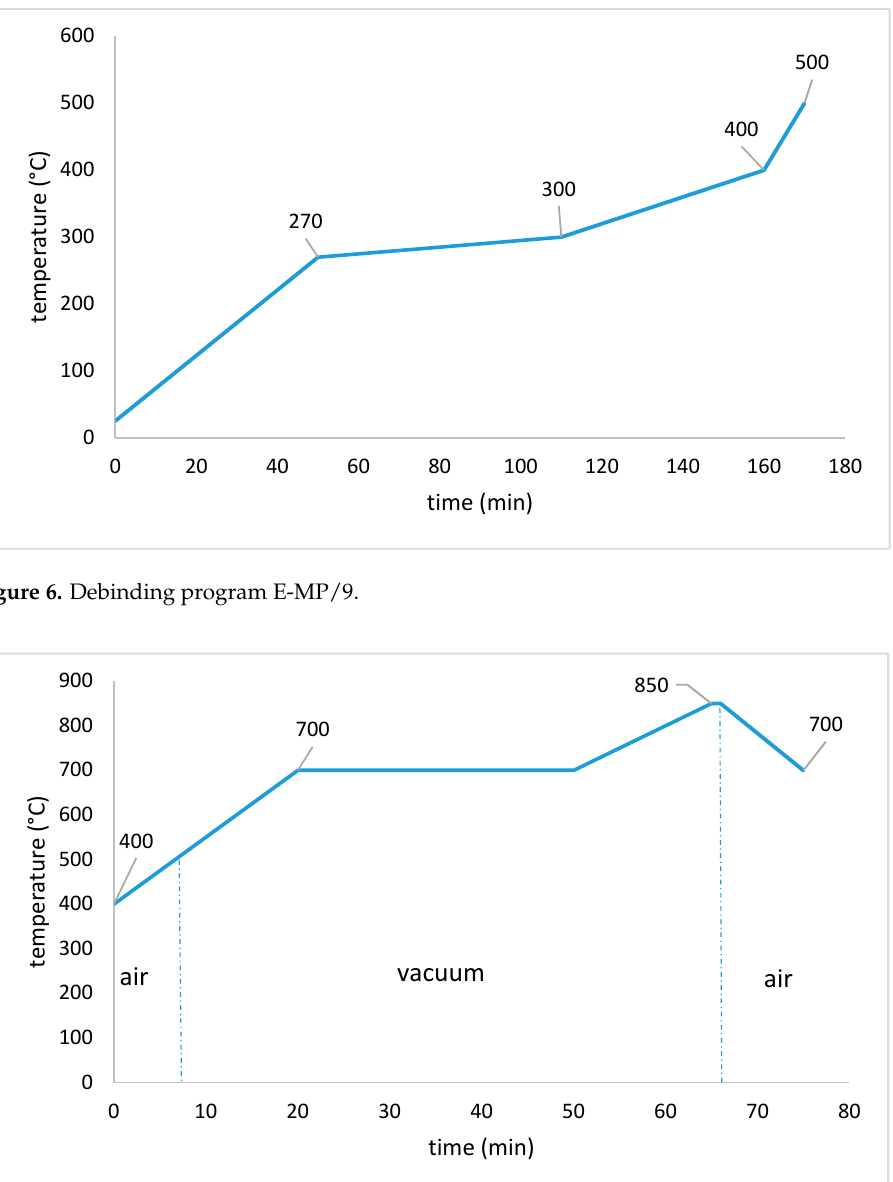
Figure 7. Sintering program RG_Lisi2_7_mod.6 .